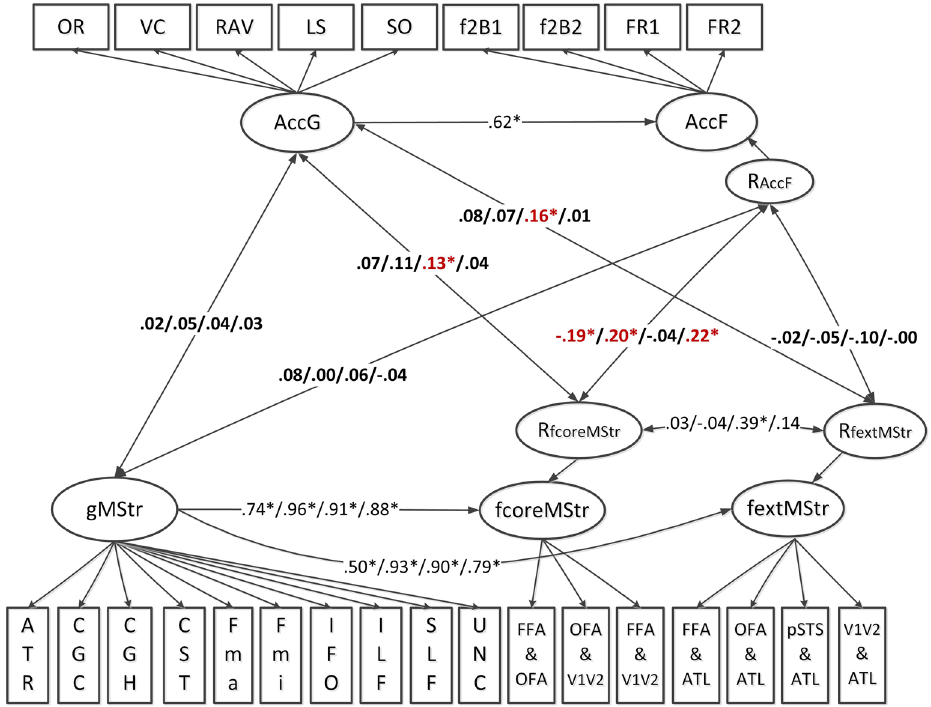
Figure 2. Schematic representation of the structural equation model estimating the linear relationship between individual differences in tract-averaged white matter microstructural properties (FA/MD/AD/RD) and response accuracy at both domain general and face-specific levels. AccG—Accuracy of general cognition; AccF—Accuracy of face processing; gMStr—Microstructural properties in global brain fibers; fcoreMStr— Microstructural properties of core face network fibers; fextMStr—Microstructural properties of extended face network fibers; RfcoreMStr—Residual variance of the fcoreMStr factor, indicating the unique variance in fcoreMStr not explained by gMStr; RfextMStr—Residual variance of the fextMStr factor, indicating the unique variance in fextMStr not explained by gMStr; RAccF—Residual variance of the AccF factor, indicating the unique variance in AccF not explained by AccG; OR—Oral reading recognition test; VC—Vocabulary comprehension; RAV—Raven progressive matrices; LS—List sorting working memory; SO—Spatial orientation; f2B1—Facial working memory 2-back task, first scan as indicator 1; f2B2—Facial working memory 2-back task, second scan as indicator 2; FR1—Face recognition, first scan as indicator 1; FR2—Face